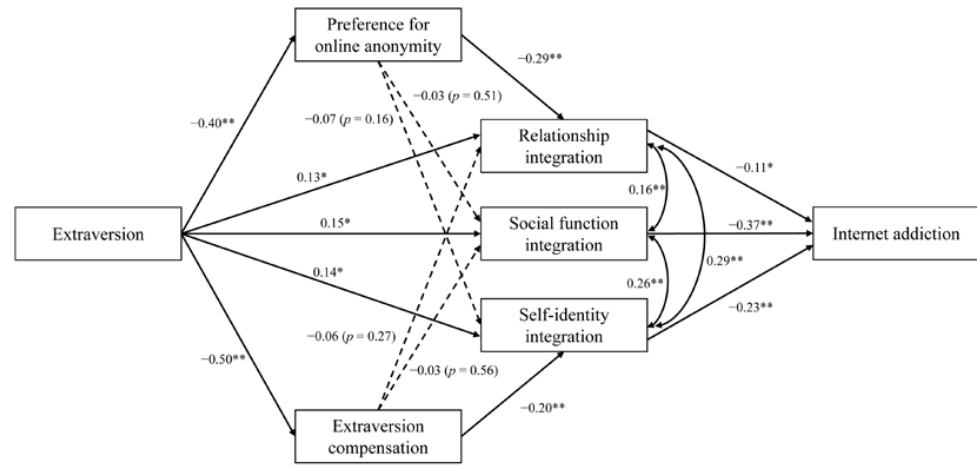
Figure 3. Results of the serial mediation model with specific integration components. Coefficients are standardized betas , * p < 0.05, ** p < 0.01.